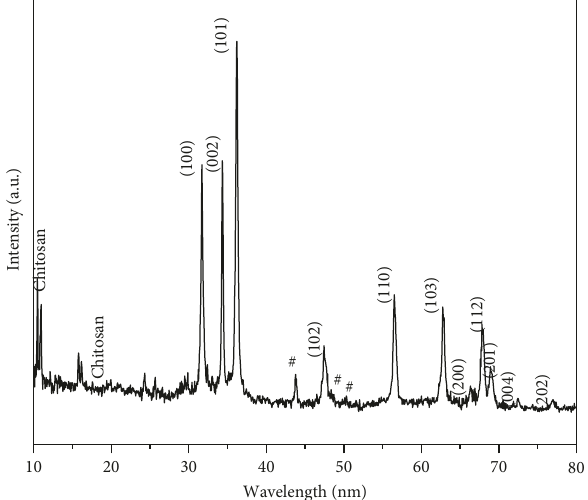
Figure 1: XRD patterns of the ZnO-TiO